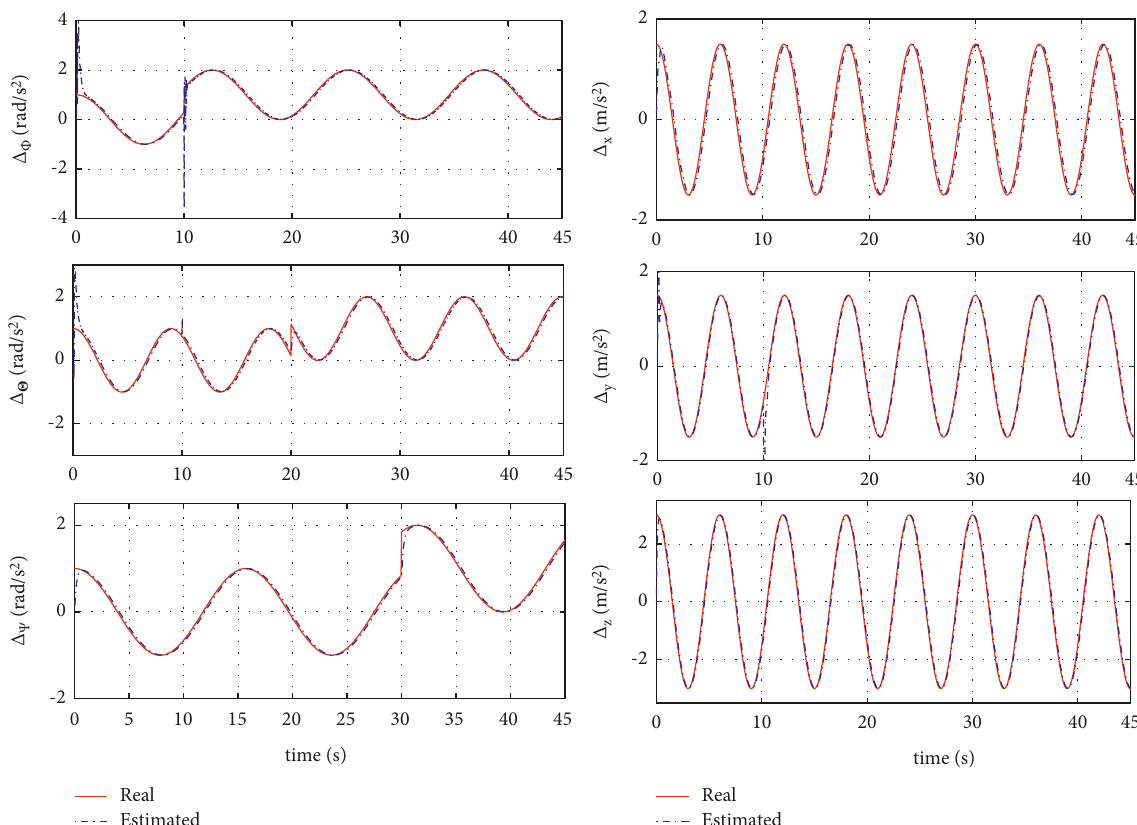
Figure 13: Estimation of the disturbances affecting the quadrotor position and